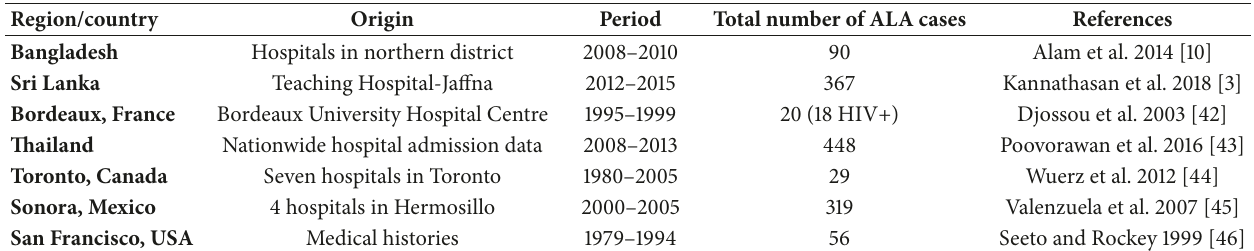
Table 1: Prevalence of ALA in different places across the